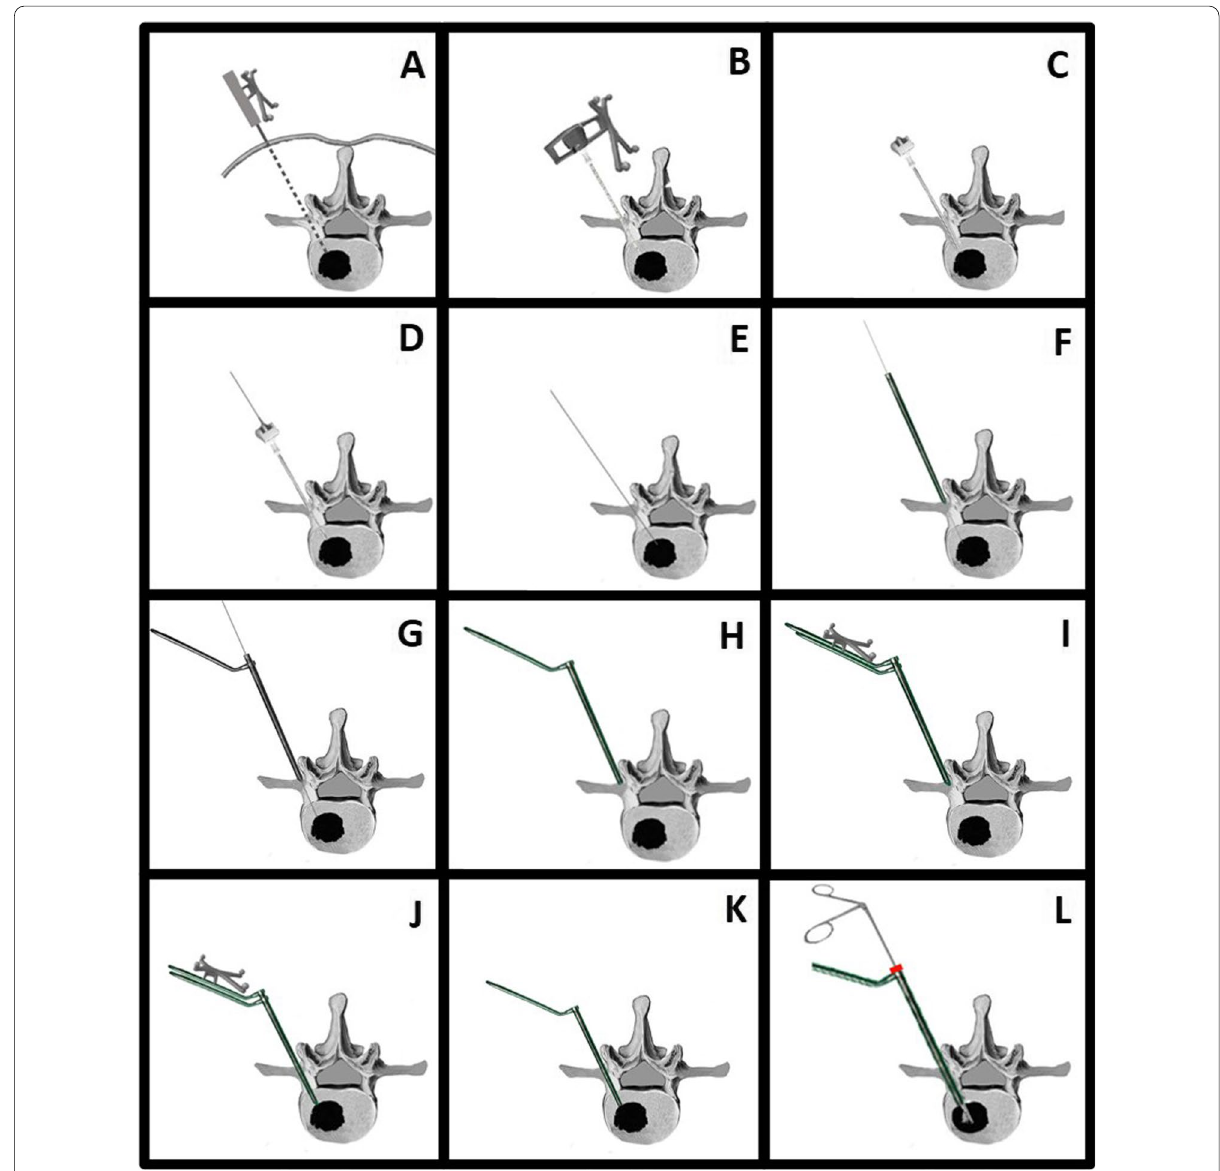
Fig. 4 Illustration showing steps of the biopsy. A Navigated PAK (Pedicle access Kit, Medtronic) needle used to get projection and then skin stab incision is put. B PAK needle is introduced and pushed to land at pediculo-facet junction. C Its trocar is introduced further to reach beyond the posterior border of body under virtual images on navigation screen. D Trocar is withdrawn. E Guide wire is introduced positioned into the vertebral body. F The outer sheath of PAK is removed. G Dilator is put on guidewire. H Serrated Biopsy canula is put on the dilator & guide wire to reach pediculo-facet junction I Then guide pin & dilator are removed. J The third party tracker guided trocar is introduced and is further pushed to reach in vertebral body safely at or beyond the pedicle to body junction under virtual images of navigation. K The trocar is removed. L The pre-calculated length of biopsy forceps is introduced and is used as per the location of biopsy target lesion with a stopper. Single shoot 2D is taken beforehand to confirm the position and